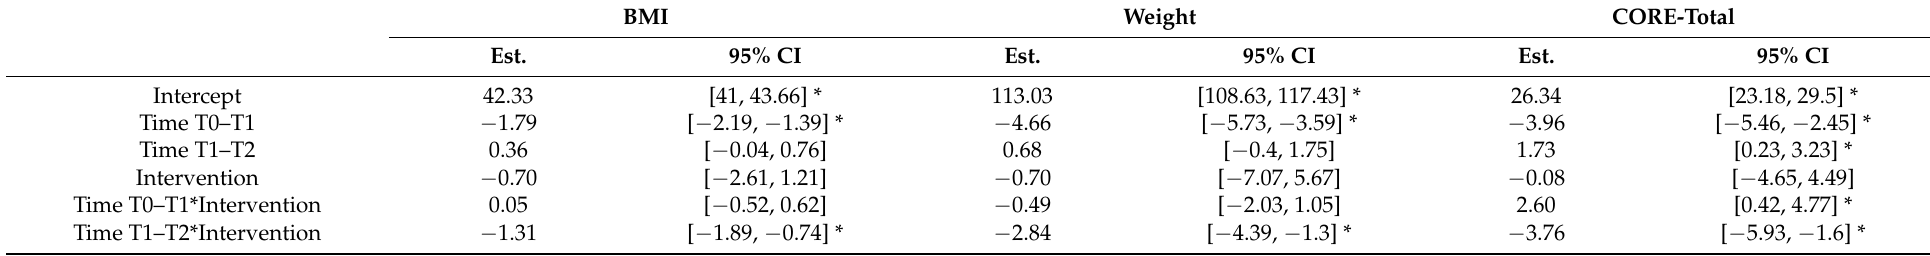
Table 3. Results of the generalized linear mixed models comparing the effects of the ACT and CBT treatments overtime on BMI, weight, and on the total score of the CORE-OM. BMI Weight CORE-Total Est. 95% CI Est. 95% CI Est. 95% CI Intercept 42.33 [41, 43.66] *